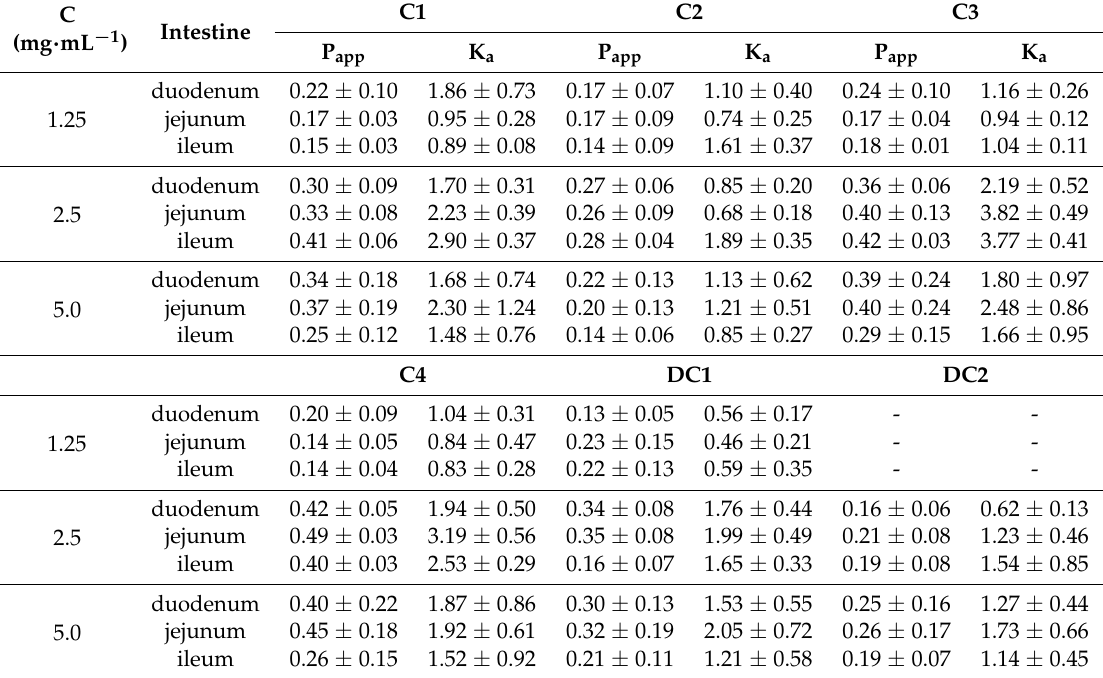
Table 2. P app and K a of C1, C2, C3, C4, DC1, and DC2 obtained from in situ single-pass perfusion administrated in MDQ-TS form ( n =